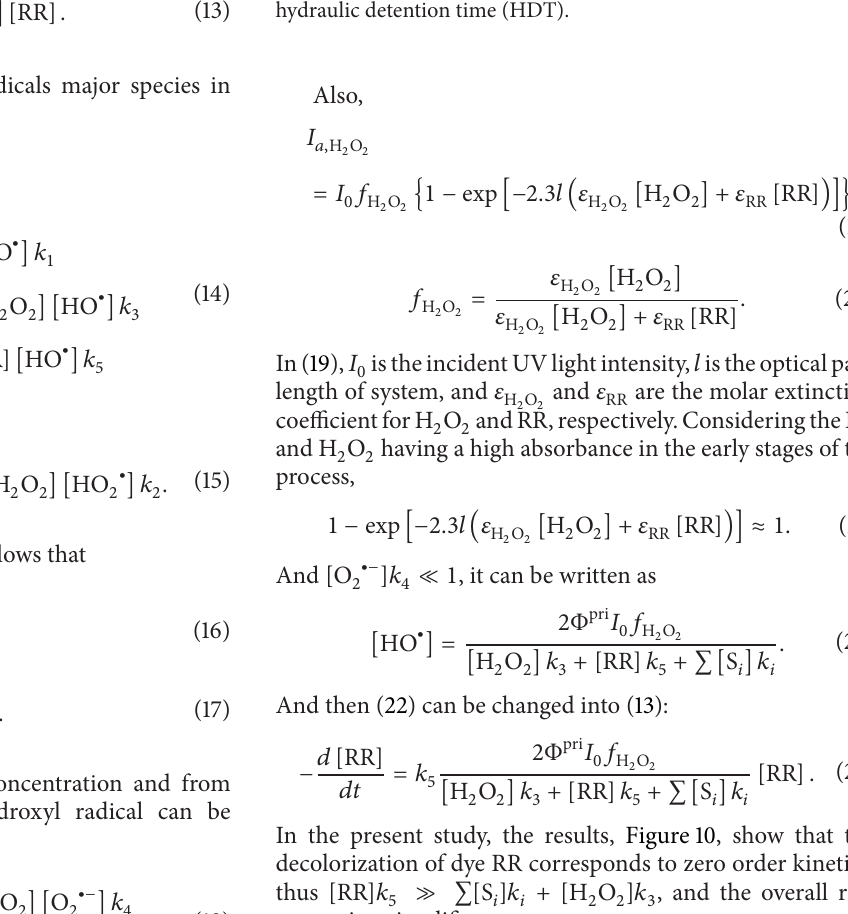
Figure 10: Zero order representation for RR decolorization versus time; pH = 10; 𝑇 = 25 ∘ C; the irradiation time calculated from the hydraulic detention time